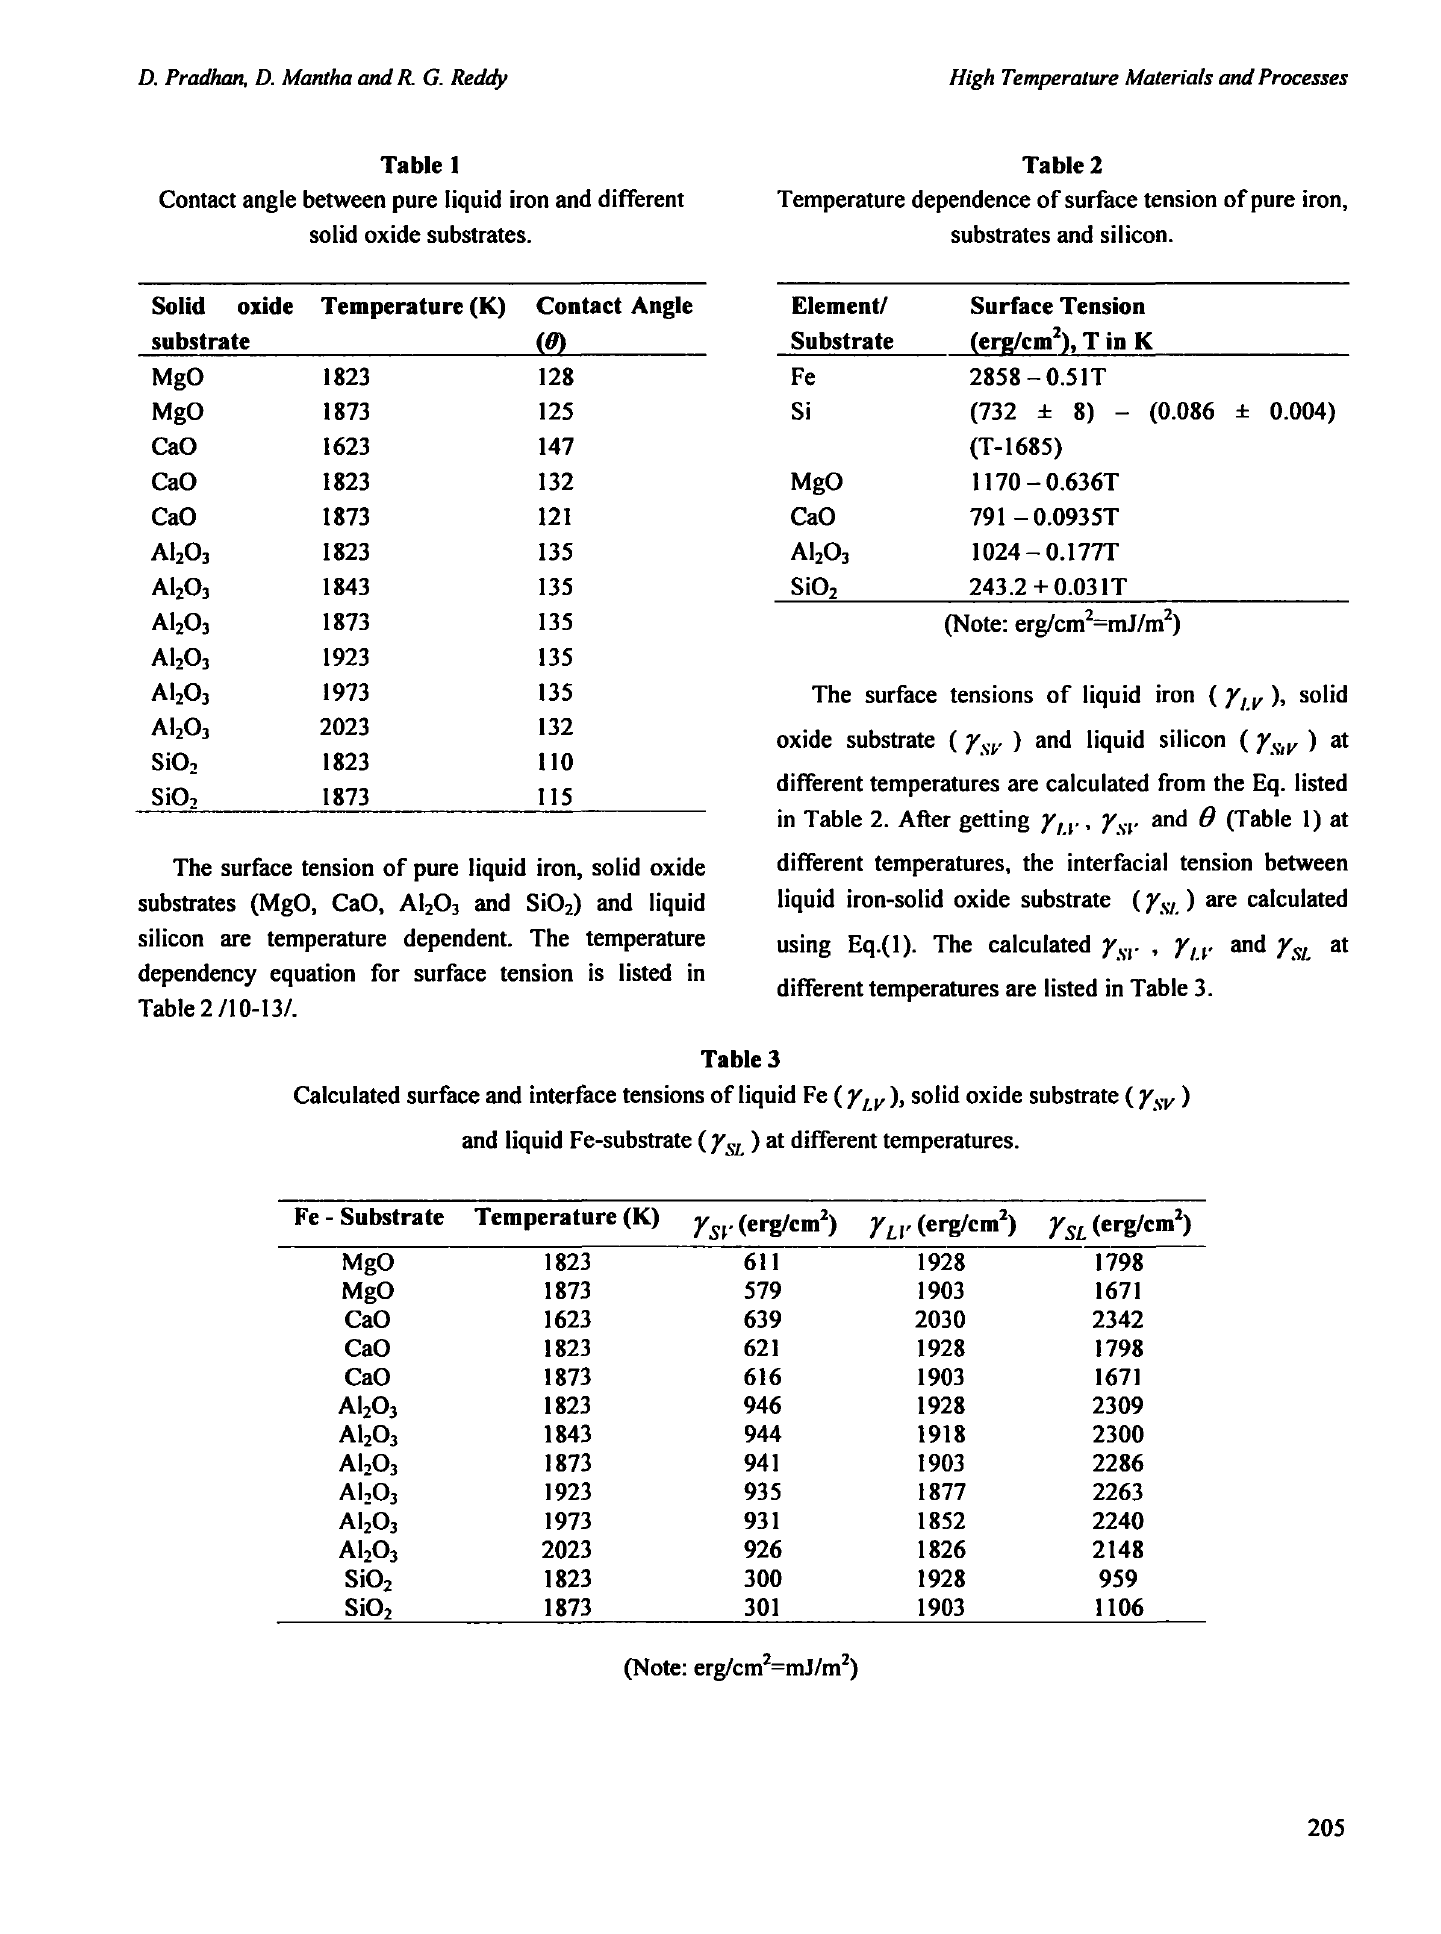
Temperature dependence of surface tension of pure iron, substrates and silicon.